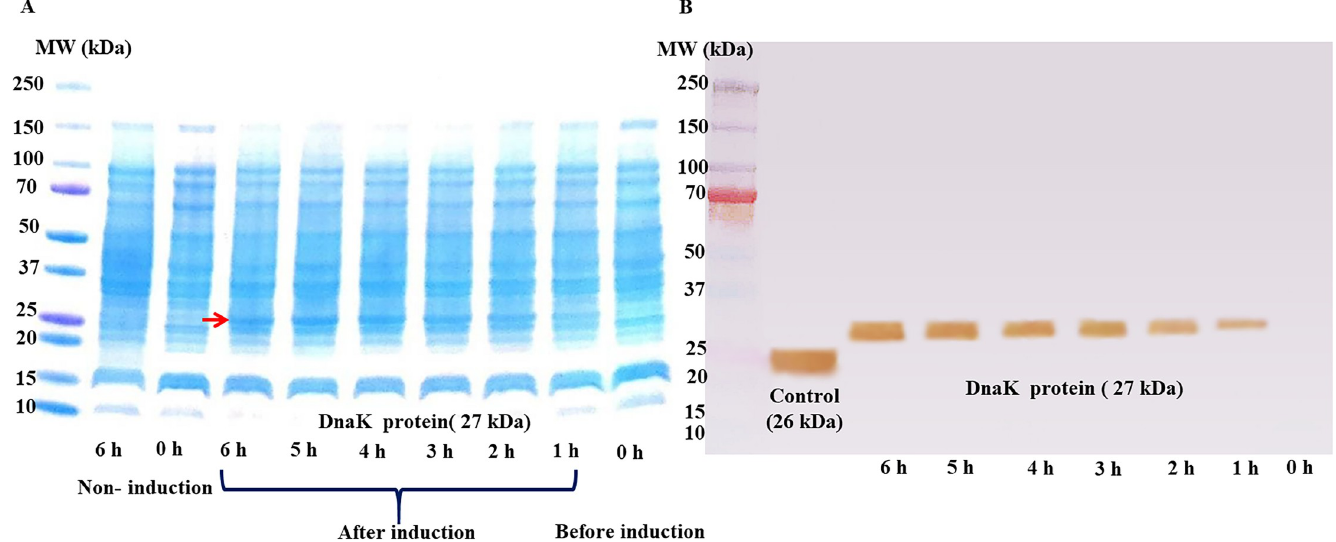
Fig 5. SDS-PAGE and western blotting of recombinant partial DnaK protein from CLE of R . annulatus . (A) SDS-PAGE showing the separated protein lysates from Escherichia coli had an MW of 27 kDa for partial DnaK of the CLE from R . annulatus (red arrow) after induction with IPTG in the log growth phase. (B) Western blotting indicated the recombinant protein had a MW of 27 kDa after induction with IPTG for various amounts of time.